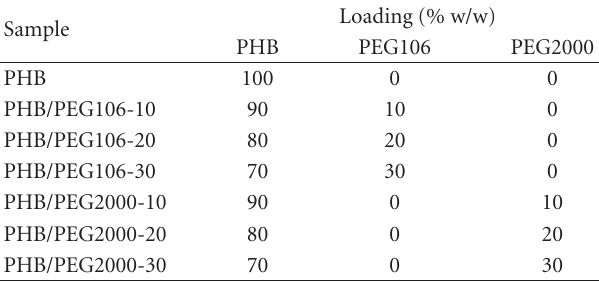
Table 1: Nomenclature of biomaterial films prepared in this